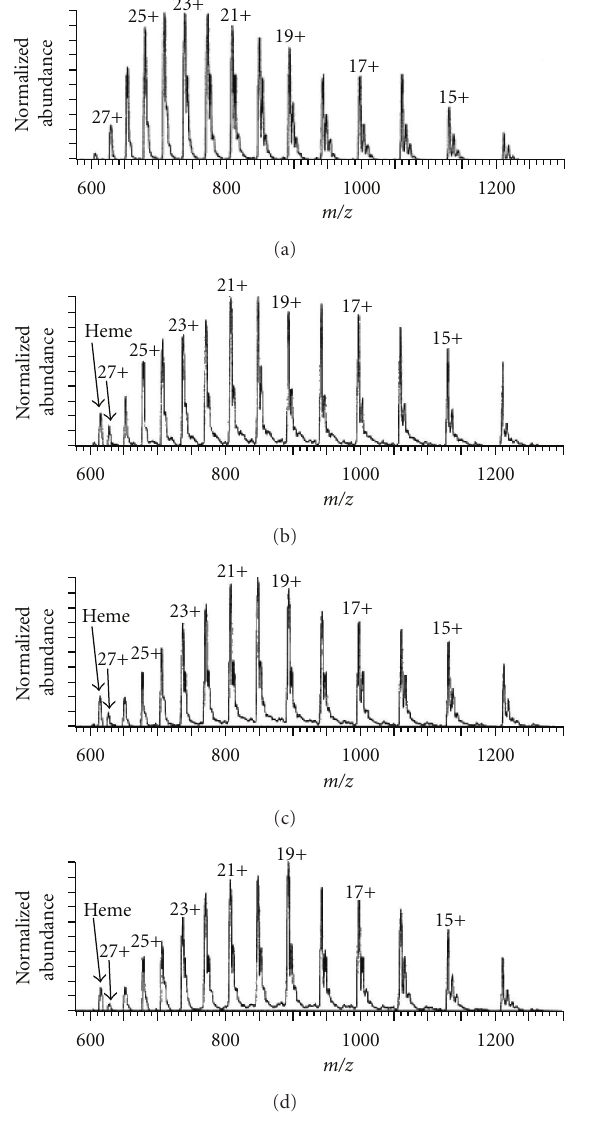
Figure 14: Myoglobin (10 − 5 M) electrosprayed from 47%/50%/3% water/solvent/acetic acid solutions, where the “solvent” was (a) water, (b) methanol, (c) acetonitrile, or (d) isopropanol. (Reprinted with permission from Journal of the American Society for Mass Spec- trometry [96], Copyright 2000, Elsevier).